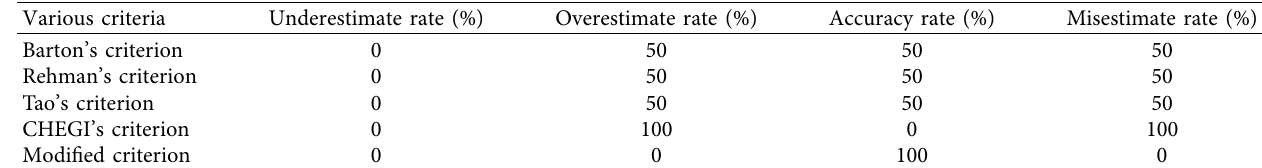
Table 16: Comparison between actual rock burst grades and estimated results.